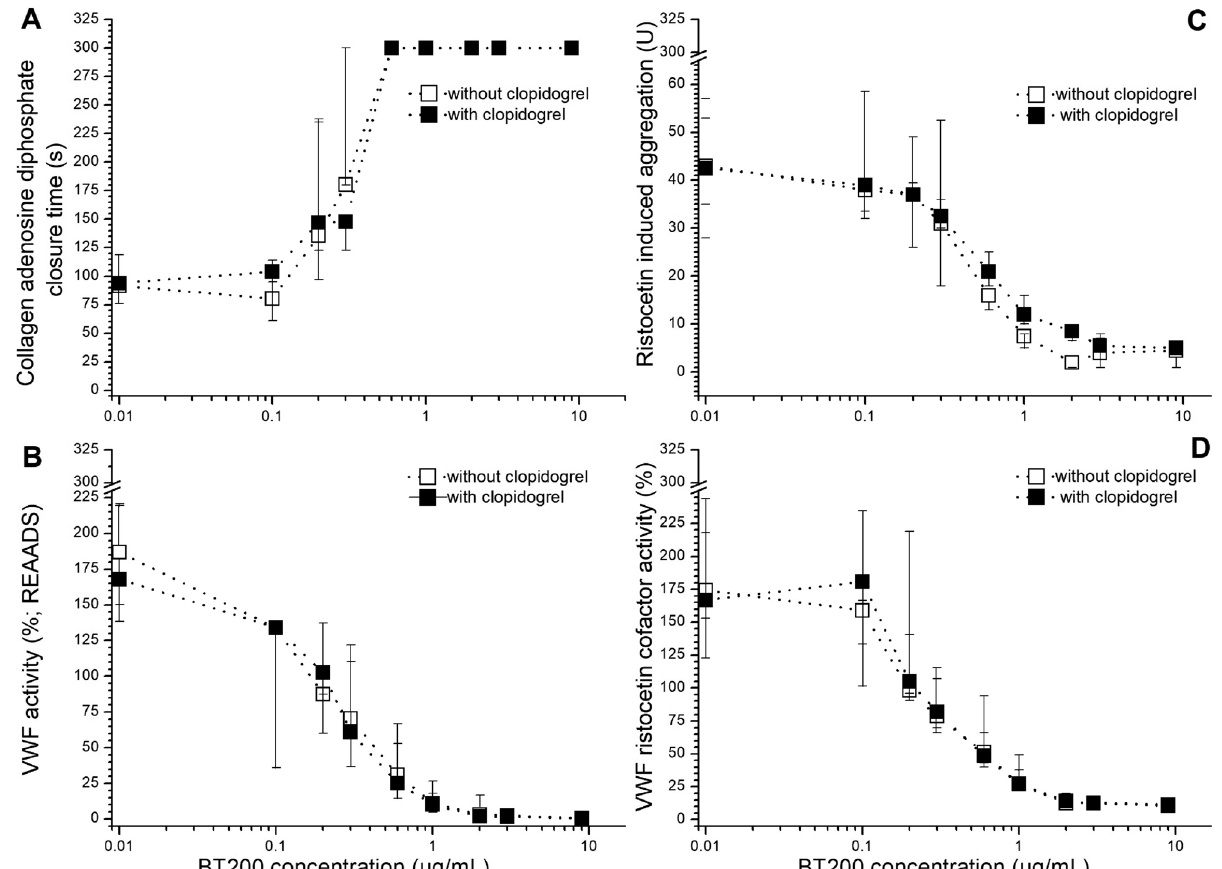
Figure 3. Concentration effect curves of BT200 on platelet plug formation under high shear stress ( A ), ristocetin-induced platelet aggregation ( B ), von Willebrand Factor (VWF) activity ( C ) and ristocetin cofactor activity (VWF:RCo) ( D ) in patients with large artery atherosclerosis stroke or transient ischemic attacks with (n = 18) or without clopidogrel therapy (n = 15). Data are presented as median values and the interquartile range, and baseline is presented as 0.01 for better visualization on the log